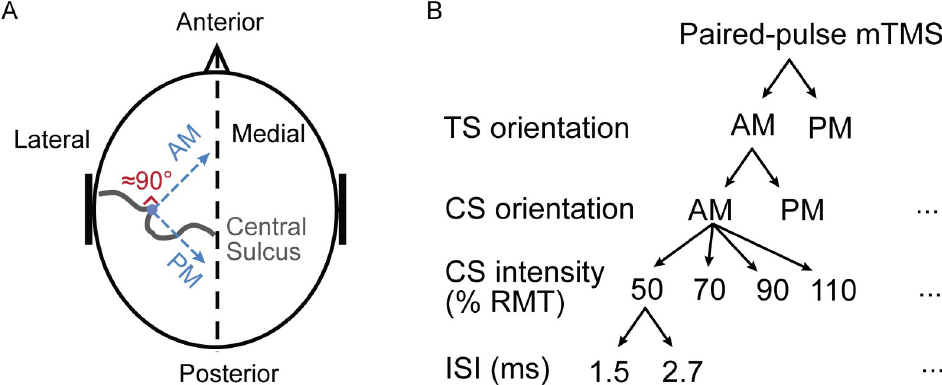
Fig 1. Experimental protocol. (A) Schematic representation of the stimulus orientations. The APB hotspot is indicated as a blue dot. The AM orientation of the E-field is approximately perpendicular to the central sulcus (gray curve). The PM is oriented 90˚ clockwise from the AM. (B) Schematic representation of paired-pulse stimulation. Thirty-two paired-pulse configurations were utilized based on the following features: Two orientations of the CS: AM and PM; two orientations of the TS: AM and PM; four CS intensities: 50, 70, 90, and 110% RMT; two ISIs: 1.5 and 2.7 ms. The ellipsis indicates an intentional omission of the subdivision for all configurations, except for the first one.